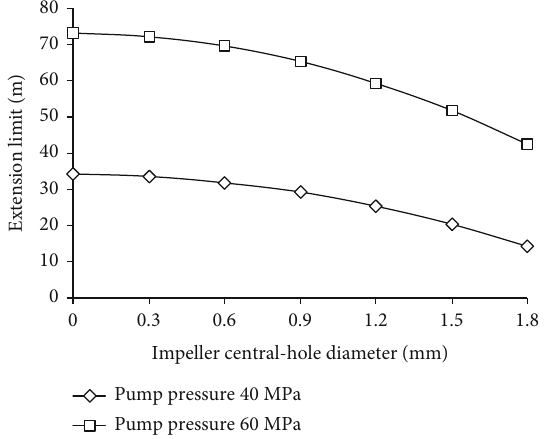
Figure 8: Extension limit in fl uenced by the impeller central hole.